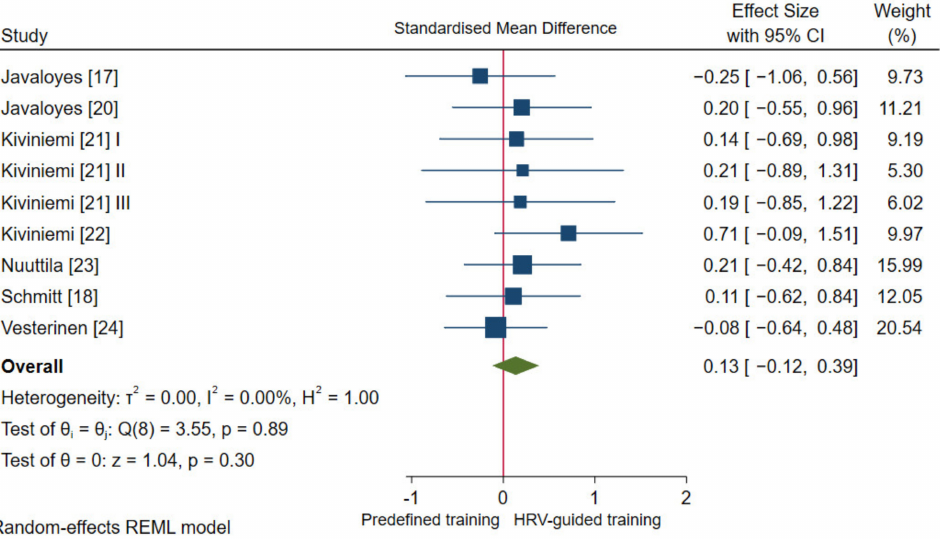
Figure 4. Forest plot of standardized mean difference indices for units from the same